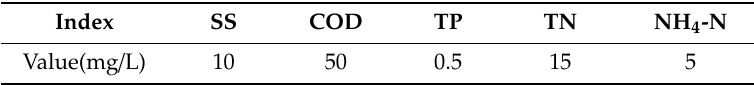
Table 7. Standard values of first grade A sewage discharge.